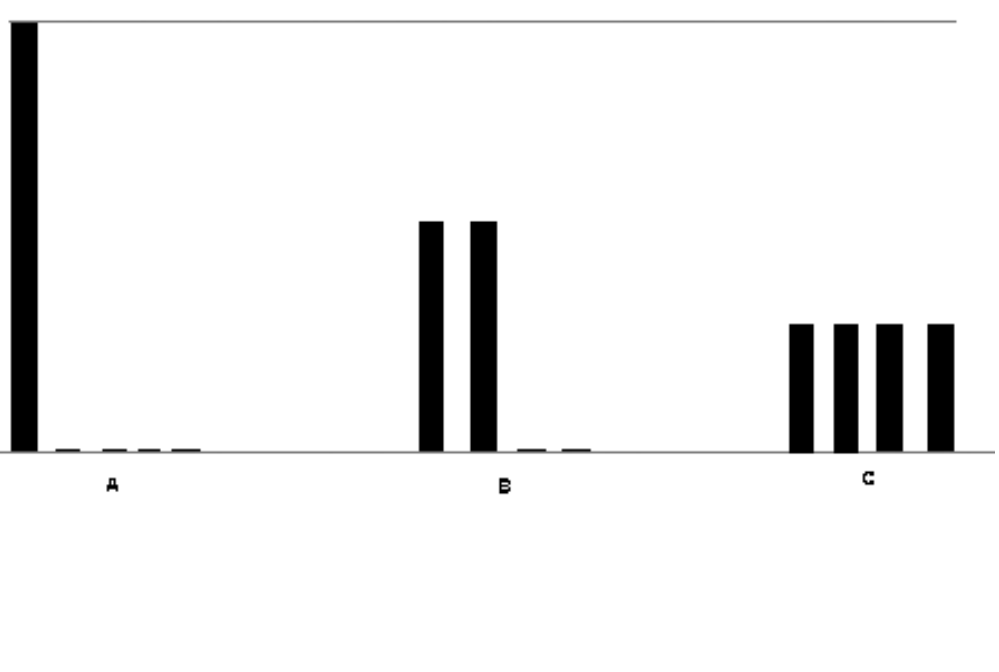
Figure 3. Intermediate evenness. Community A is a maximally uneven four-species community. Community C is perfectly even. Community B is exactly intermediate in evenness and